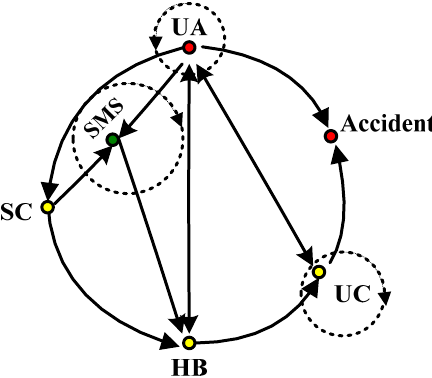
Figure 11. Improved 24Model module dynamic structure.